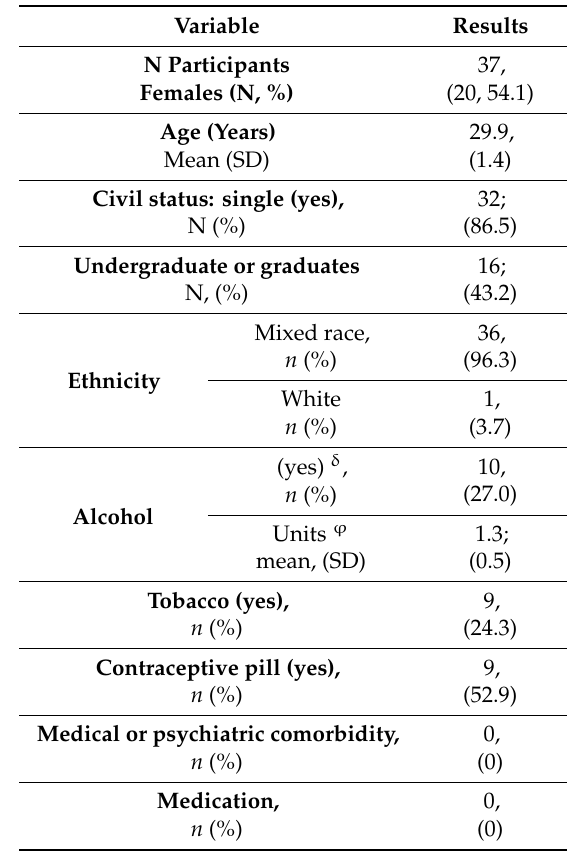
Table 1. Socio Demographic